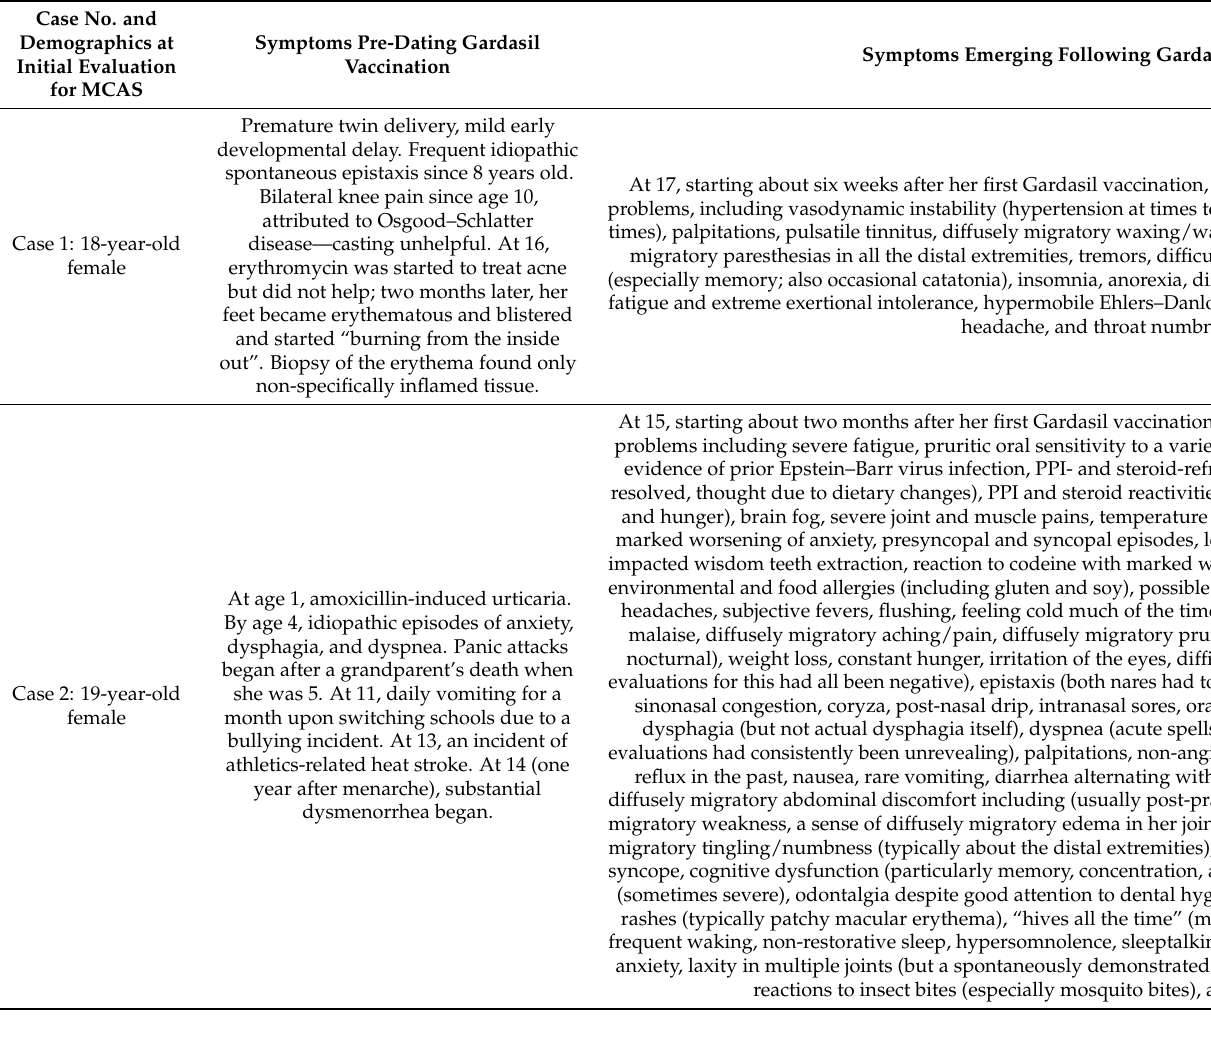
Table 1. Symptoms and key laboratory results for the described cases of post-Gardasil mast cell activation syndrome (MCAS) with postural orthostatic tachycardia syndrome